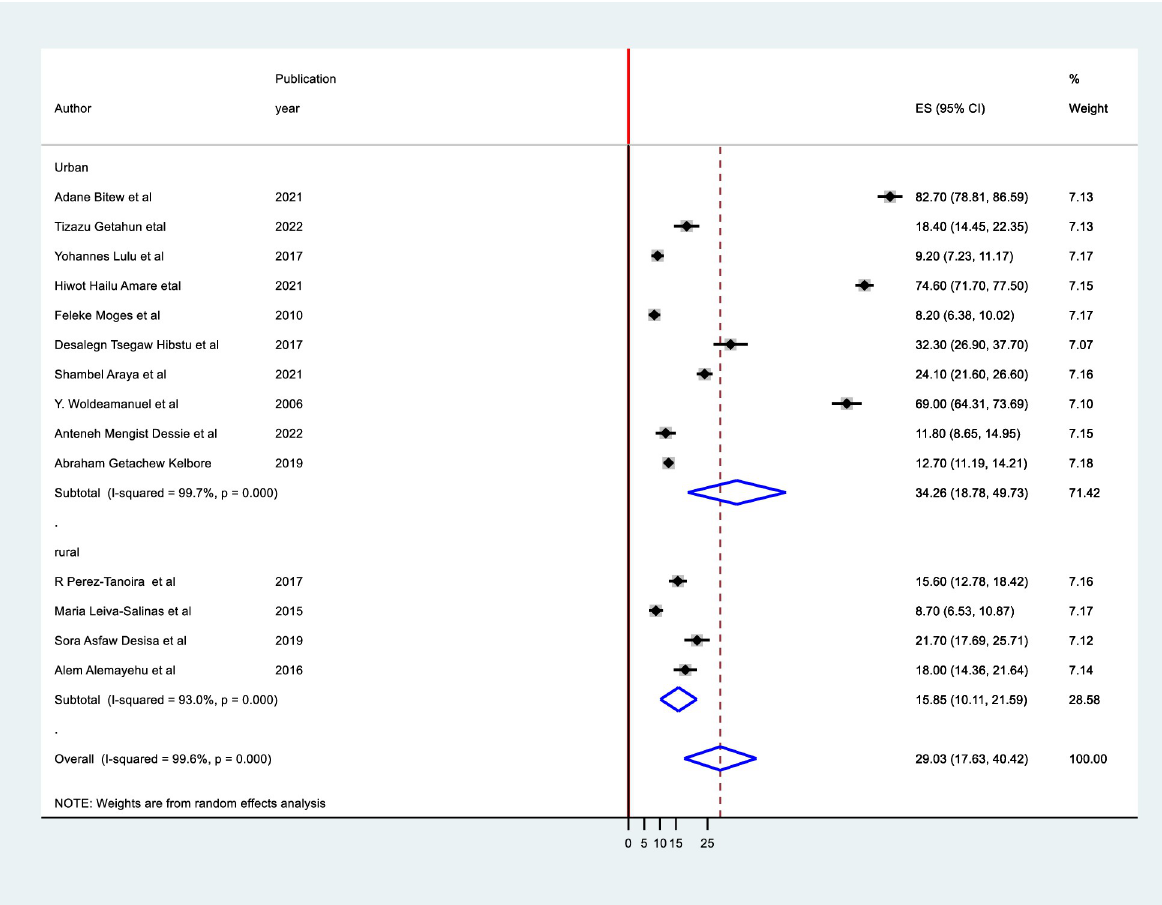
Fig 4. Subgroup meta analysis of tinea capitis over publication